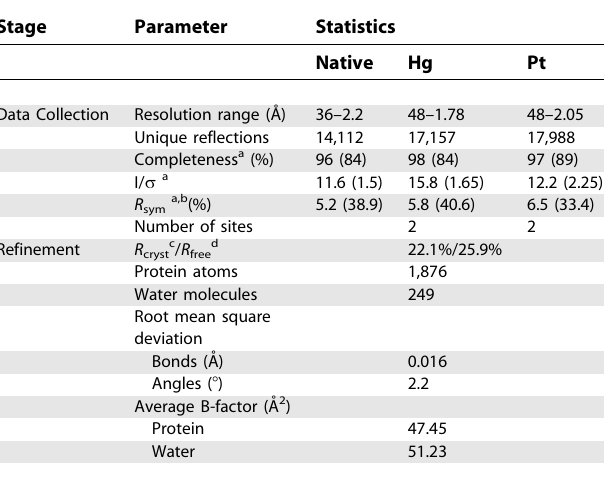
Table 1. Statistics from the Crystallographic